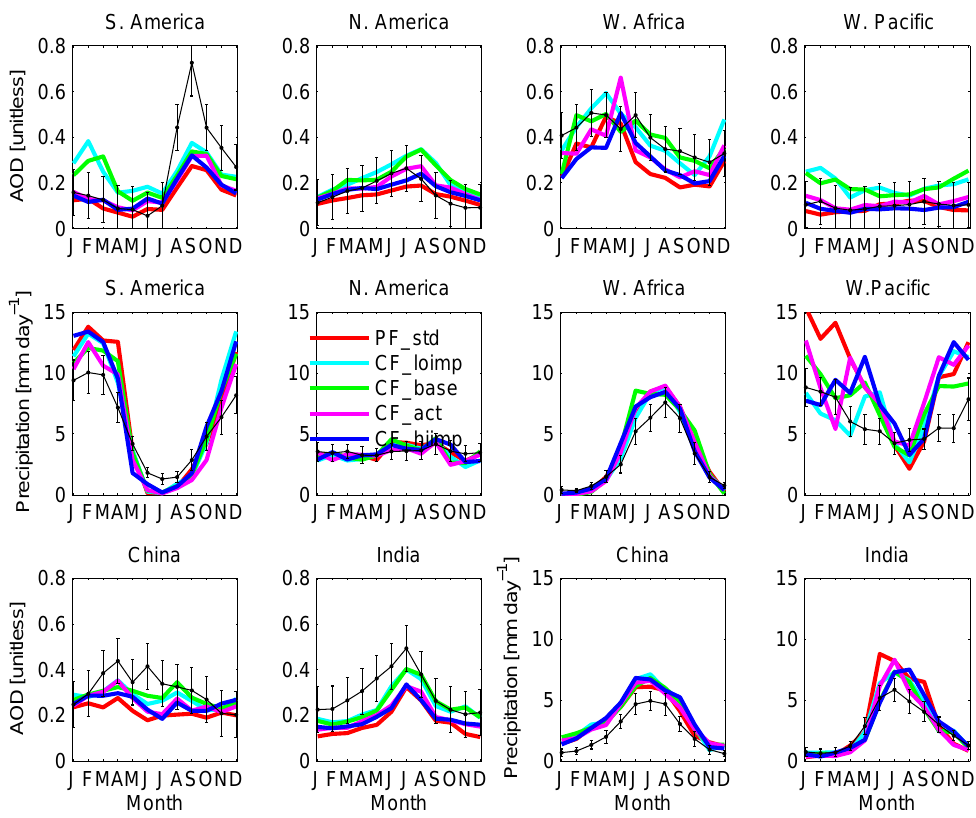
Fig. 7. Regional and monthly mean aerosol optical depth (AOD) and precipitation from the MODIS/MISR/AERONET retrieval of van Donkelaar et al. (2010) and the Global Precipitation Climatology Project retrieval (Adler et al., 2003; Hoffman et al., 2009), respectively in black, and for the five simulations for regions of South America (50–70 ◦ W and 5–15 ◦ S), North America (60–90 ◦ W and 25–45 ◦ N), West Africa (20–0 ◦ W and 5–15 ◦ N), West Pacific (170–190 ◦ E and 5–15 ◦ S), China (95–125 ◦ E and 20–45 ◦ N), and India (65–95 ◦ E and 5–35 ◦ N) in color as indicated by the legend. Error bars representing uncertainty in the retrievals are also in black. Simulations are described in Table 1. Legend applies to all